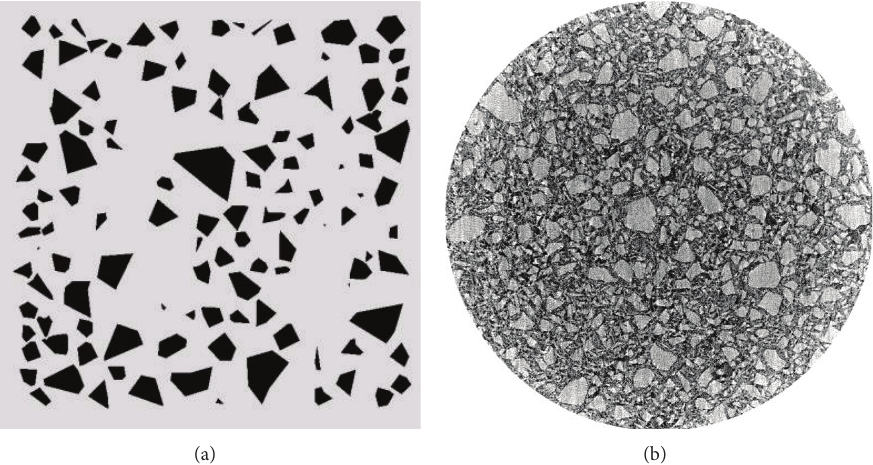
Figure 7: (a) Section of the simulated structure (1000 octahedron grains in 10 ∼ 50 𝜇 m size range); (b) 2D section of a real fresh cement structure (Cement-133) obtained by X-ray microtomography; w/c = 0.35. Source: http://visiblecement.nist.gov/cement.html.